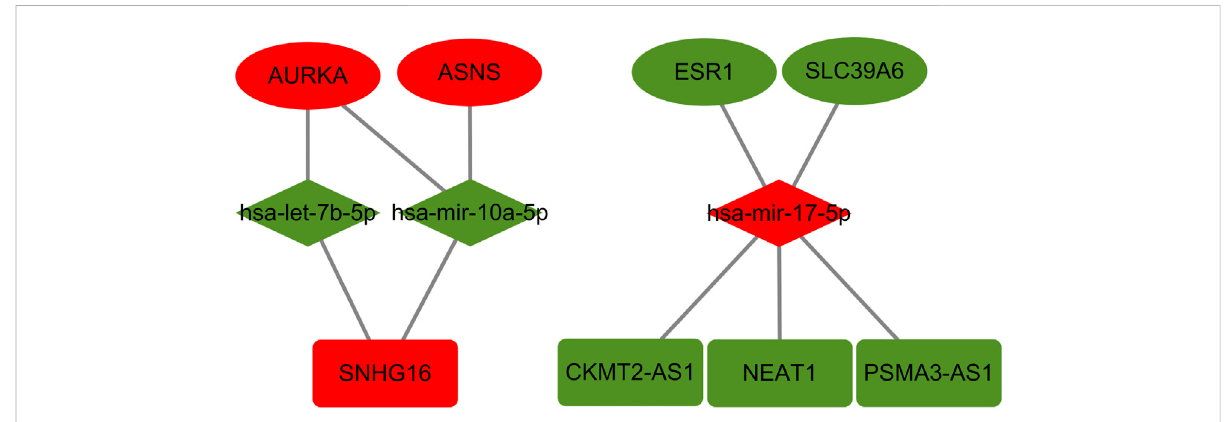
FIGURE 6 Prognosis-related genes in TMX-resistant BC. Ovals in the fi gure represent mRNAs, red ovals represent upregulated mRNAs and green ovals represent downregulated mRNAs; the diamonds represent miRNAs, red diamonds represent upregulated miRNAs and green diamonds represent downregulated miRNAs; the rectangles represent lncRNAs, red rectangles represent upregulated lncRNAs and green rectangles represent downregulated lncRNAs.